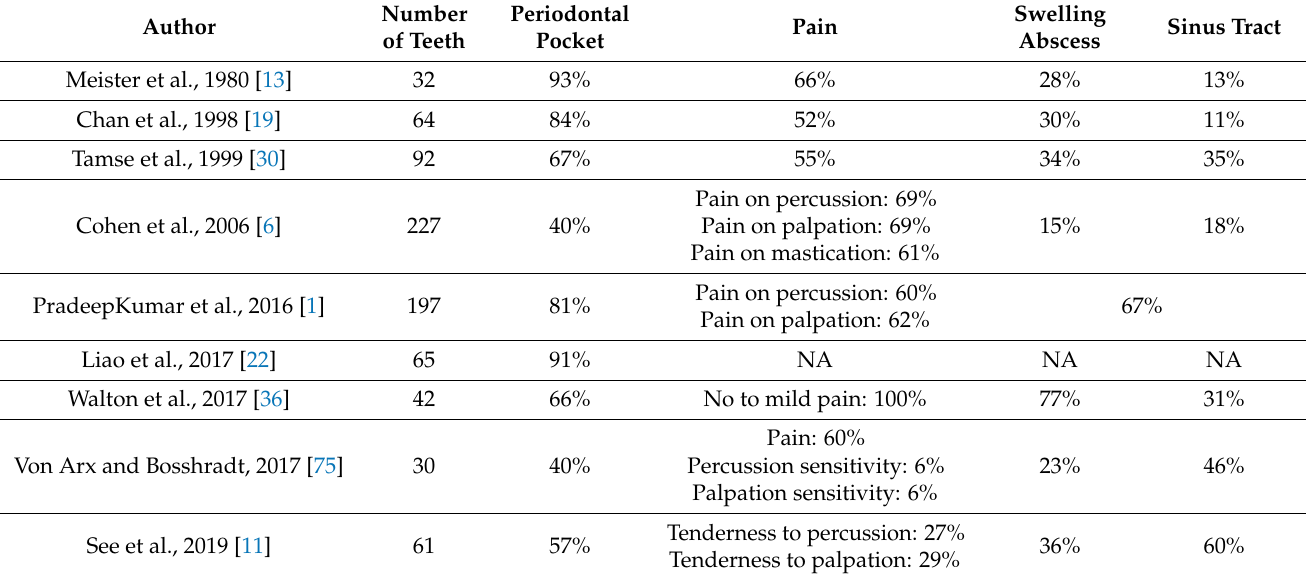
Table 1. Clinical symptoms and signs of a vertical root fracture